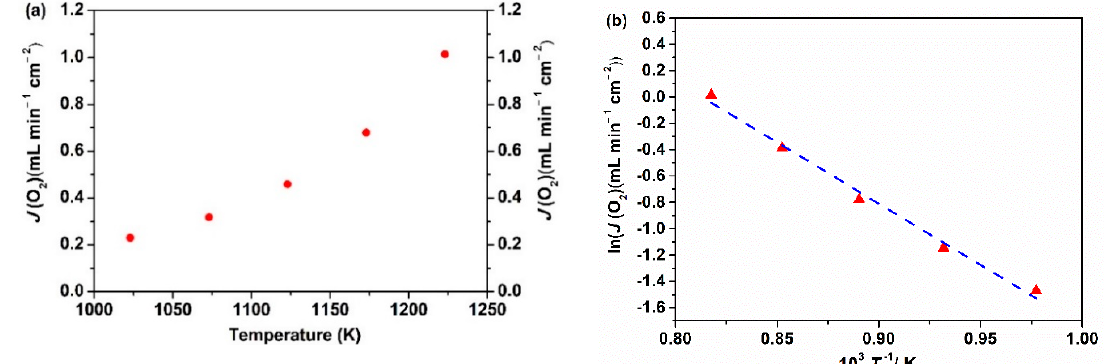
Figure9. Oxygenpermeationfluxes( a )anditsArrheniusplot( b )oftheCe 0.9 Pr 0.1 O 2 − δ –Nd 0.5 Sr 0.5 Fe 0.9 Cu 0.1 Figure 9. Oxygen permeation fluxes ( a ) and its Arrhenius plot ( b ) of the Ce 0.9 Pr 0.1 O 2 − δ – O 3 − δ dual-phase membrane (thickness: 0.6 mm) under an air / He Nd 0.5 Sr 0.5 Fe 0.9 Cu 0.1 O 3 − δ dual-phase membrane (thickness: 0.6 mm) under an air/He gradient.